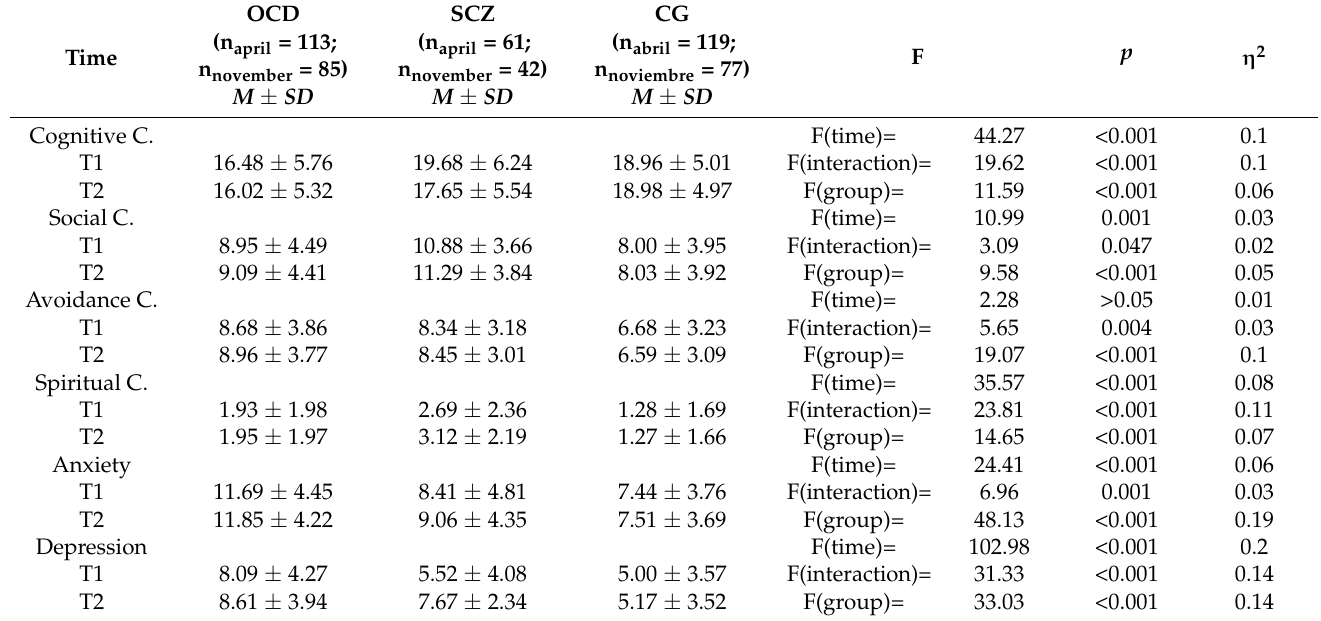
Table 2. ANOVA mixed in coping strategies, anxiety and depression.